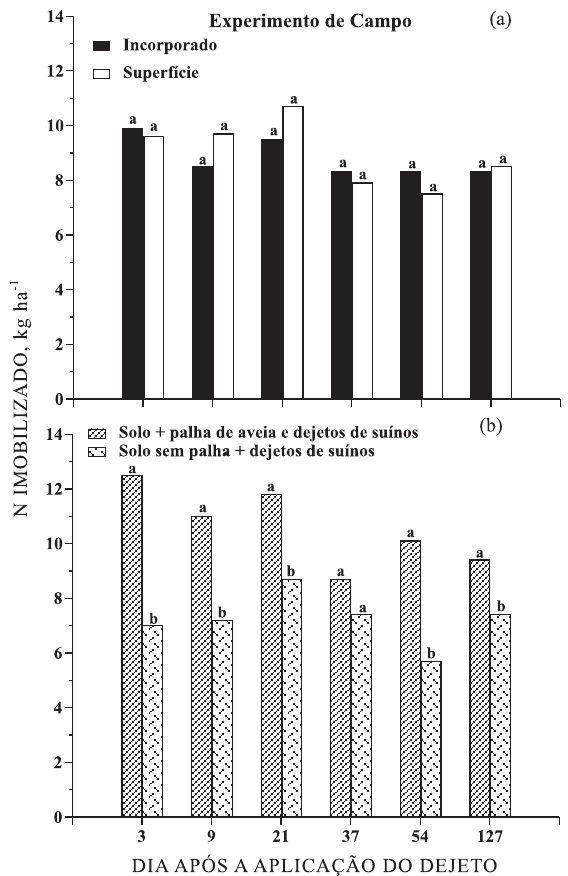
Figura 1. Quantidade de N imobilizado na camada de 0–10 cm, derivado do N amoniacal aplicado com os dejetos líquidos de suínos na superfície ou incorporados ao solo (a), com ou sem palha de aveia (b). Valores seguidos da mesma letra em cada data de avaliação não apresentam diferenças significativas entre si pelo teste de Tukey, a